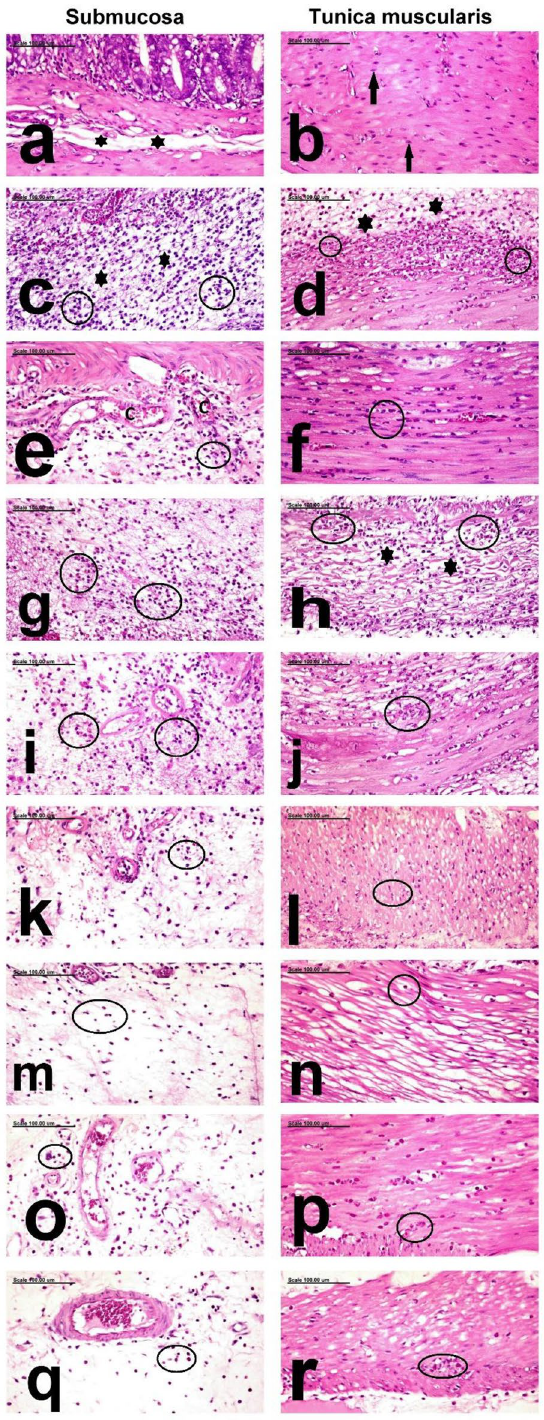
Figure 5. Photomicrograph showing the edematous and inflammatory reaction of the colonic submucosa and musculosa photomicrograph from the colon submucosa and T.muscularis of, ( a , b ) negative control rats showing normal submucosa (astrix) ( a ) and T.muscularis (black arrows) ( b ), ( c , d ) C+ ve showing expansion of the submucosa ( c ) and T.muscularis ( d ) by edematous fluids (astrix) and intense neutrophilic cell infiltration (black circle), ( e , f ) Prednisolone treated group showing congestion of the submucosal blood vessels (C) and infiltration of the submucosa ( e ) and T.muscularis ( f ) with few neutrophils (black circle), ( g , h ) Leave (250 mg/ kg)group showing intense infiltration of the submucosa with neutrophils (black circles) ( g ) and marked separation of muscle fibers of T.muscularis by edematous fluid (astrix) and leukocytic cell infiltration (black circles) ( h ), ( i , j ) the Leave (500 mg/kg)group showing intense infiltration of the sub mucosa ( i ) and T.muscularis ( j ) with neutrophils (black circles), ( k , l ) Stem (250 mg/kg) group showing mild infiltration of submucosa ( k ) and T.muscularis ( l ) with neutrophils (black circles), ( m , n ) Stem (500 mg/kg) treated group showing few neutrophils (black circles) infiltrating the submucosa ( m ) and T.muscuaris ( n ), ( o , p ) Fruit peels(250 mg/kg) treated group showing mild infiltration of the submucosa ( o ) and T.muscularis ( p ) with neutrophils (black circles), and ( q , r ) Fruit peels(500 mg/kg) treated group showing Sparse neutrophils (black circles) in the submucosa ( q ) and T.muscularis ( r ). (Stain:H&E; Scale bar = 100